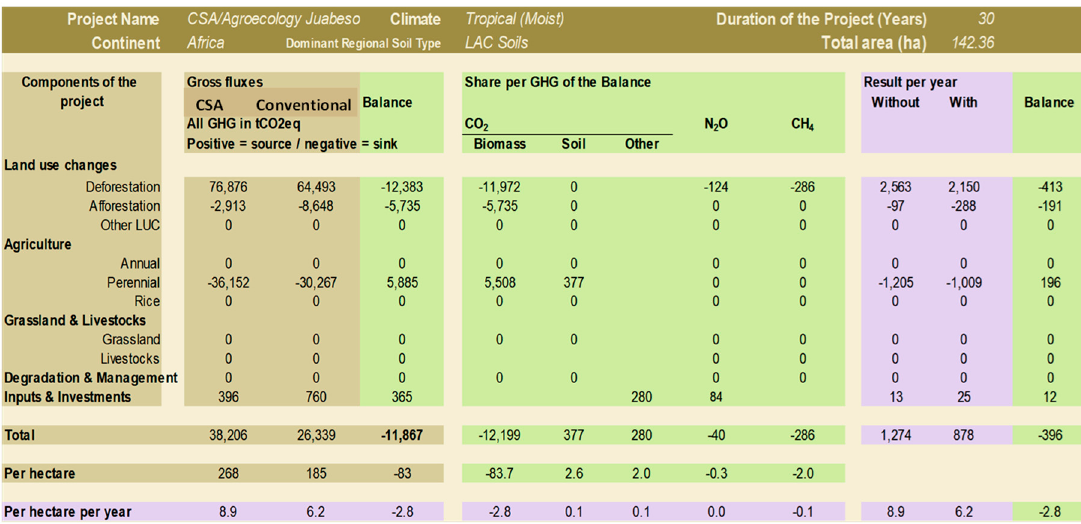
Figure 2. EX-ACT results showing fluxes per relevant component in cocoa farm projects in Juabeso Source: Field Data (2015).